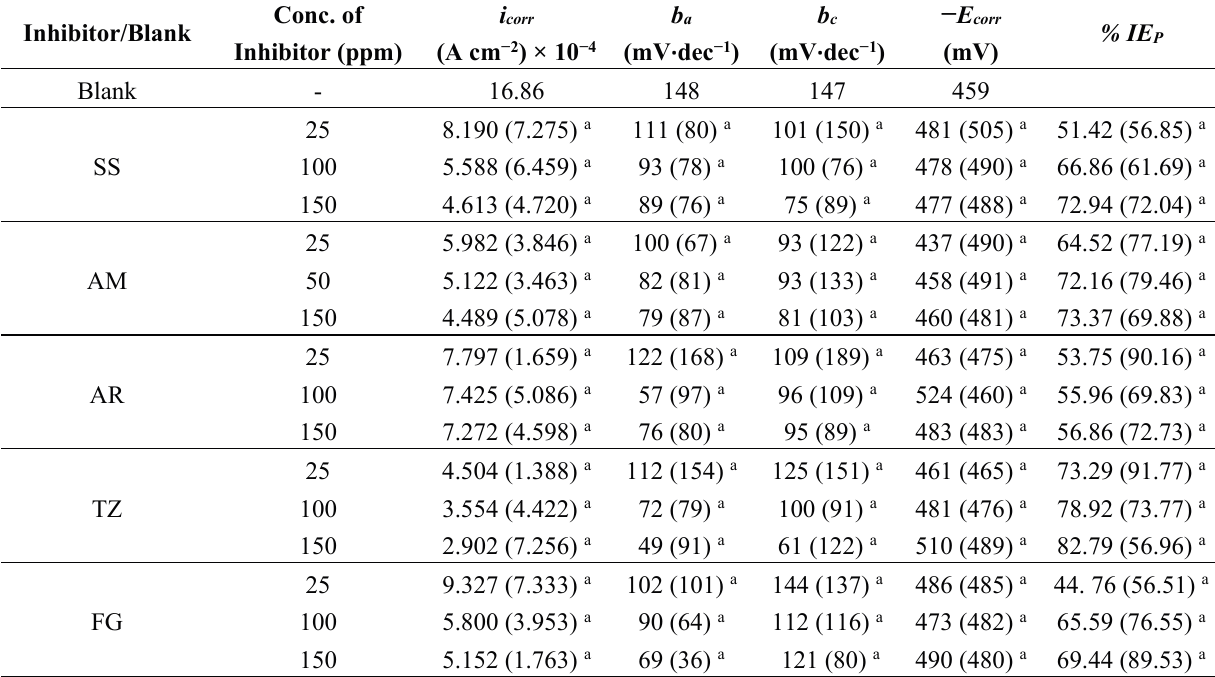
a : corresponds to results with the addition of